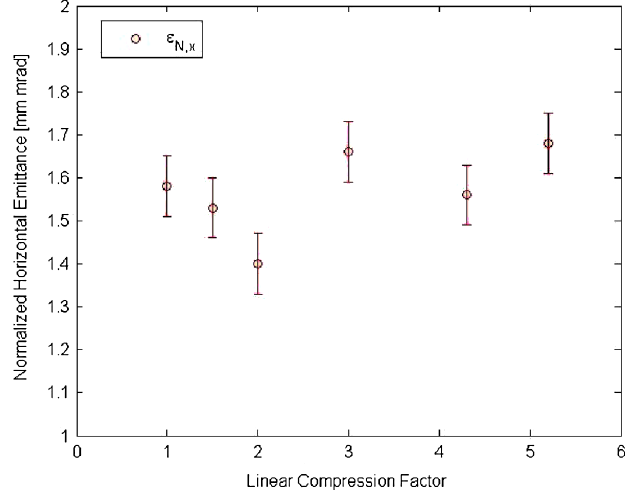
FIG. 10. " measured as a function of the compression factor, N which is varied by the L1 rf phase. BC1 is at 85 mrad bending